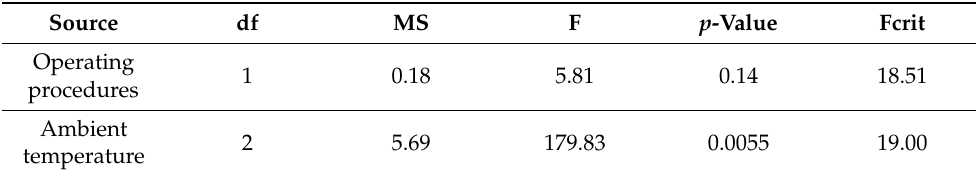
Table 4. Analysis of variance of mean skin